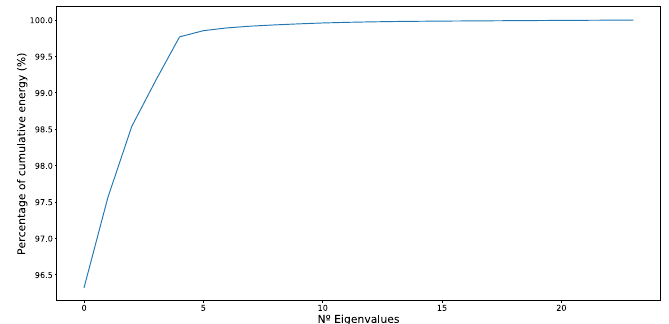
Figure 14. Graph showing the total energy of the signal captured by the linear DMD approximation versus the number of eigenvectors (modes) used to implement the transformation. This graph was obtained with a rolling window of 24 h, and is very similar to the graph for a rolling window of 168 h.